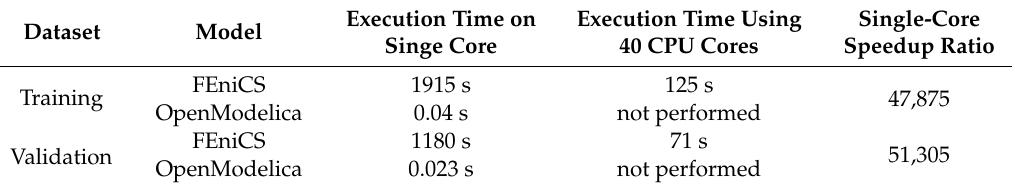
Figure 6. Accuracy of the new model for the validation dataset. Indices s, r, and a correspond to interfaces of supply, return, and air, respectively. The top part shows predicted heat flows from the domain to the adjacent media; the bottom part shows the absolute difference in predicted heat flow. Table 2. The comparison of the computational expensiveness of both models on given datasets.